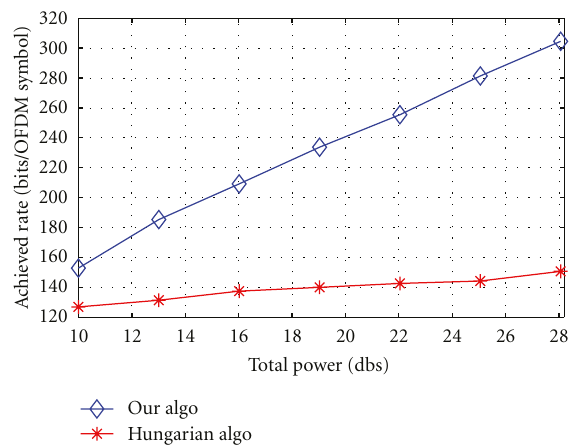
Figure 4: Percentage of packets with delay violations versus input arrival rate for all the users in the system. Users = 14, Subcarriers = 40, Cell Radius = 700m, and tti =